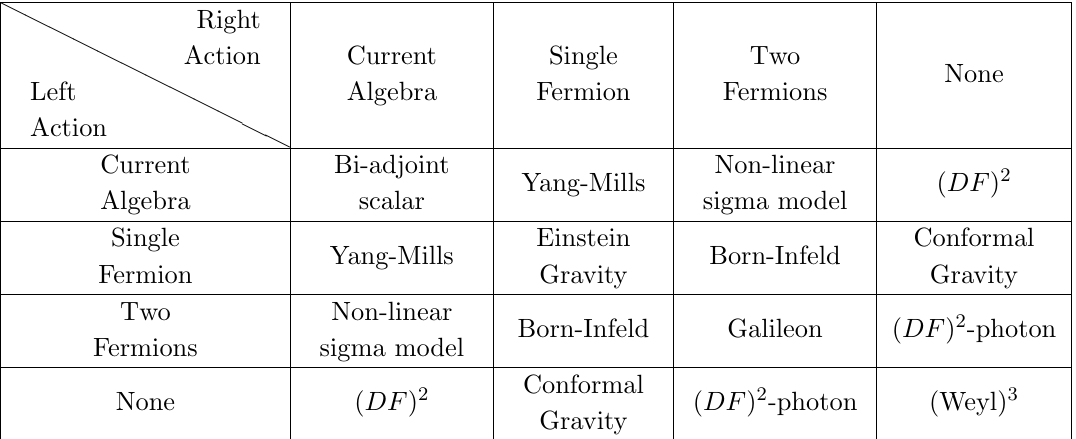
Table 1 . The matrix of ambitwistor string actions with the new row/column